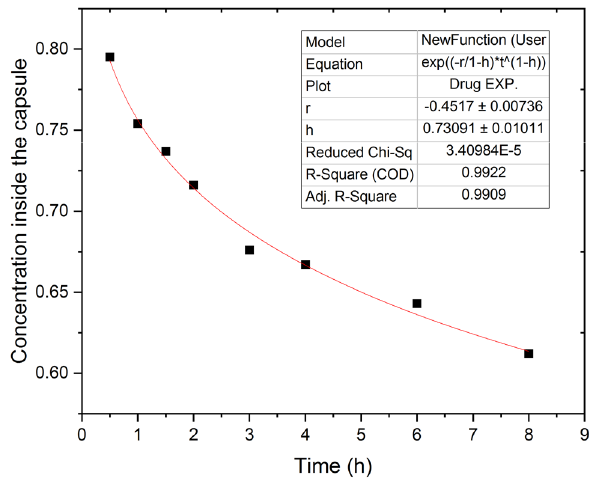
Figure 3. Fitting of the experimentally measured concentration inside the capsule using Eq. 5. The best-fitting parameter values are r=-0.45 and